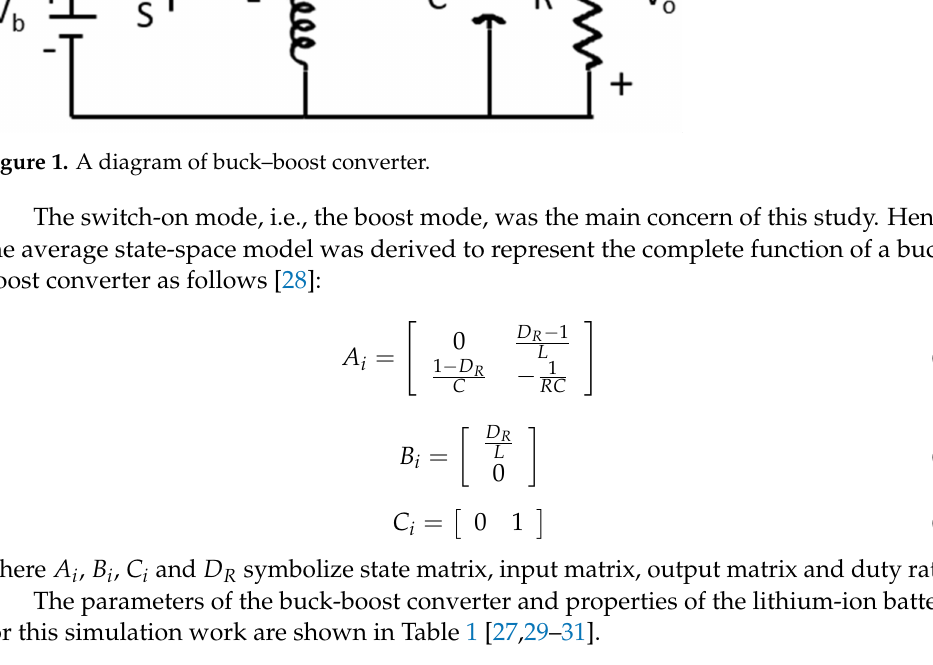
Table 1. Properties of the buck–boost converter and lithium-ion